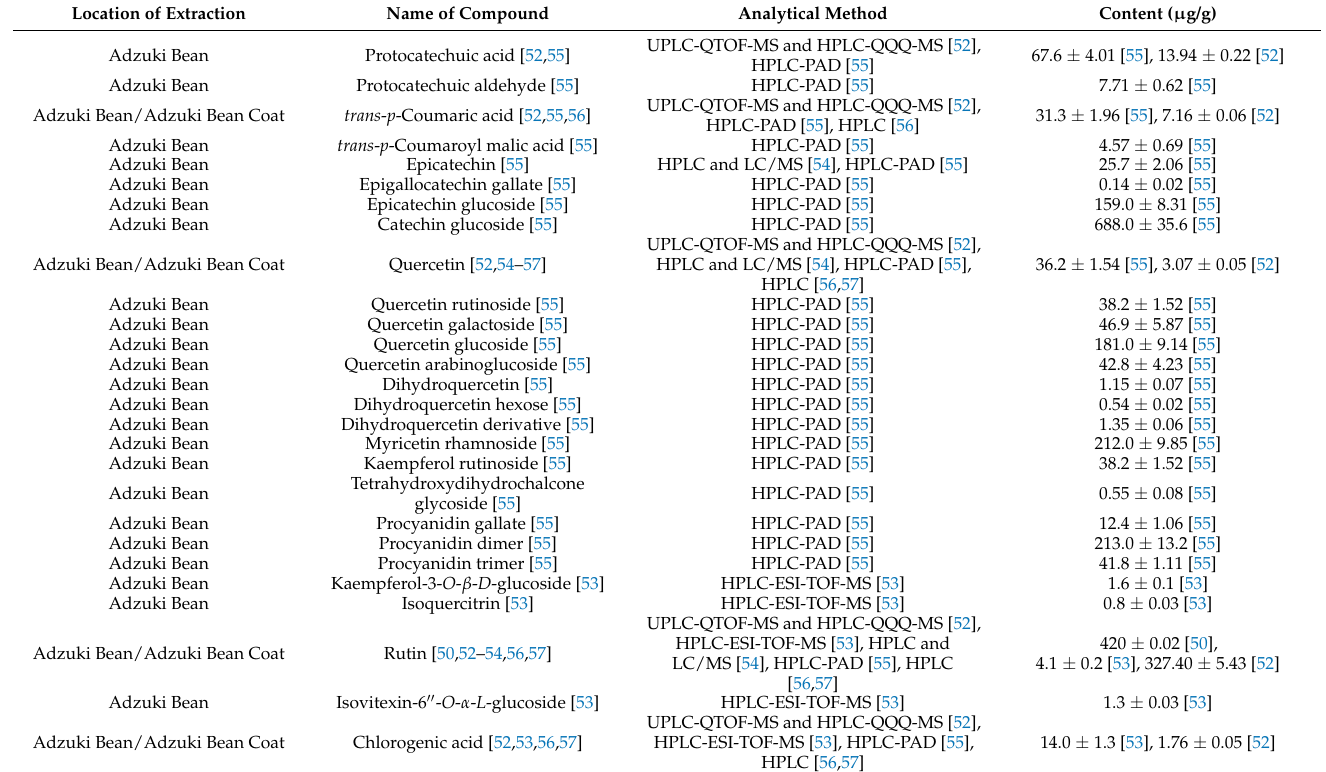
Table 1. Phenolic compounds and their contents in adzuki